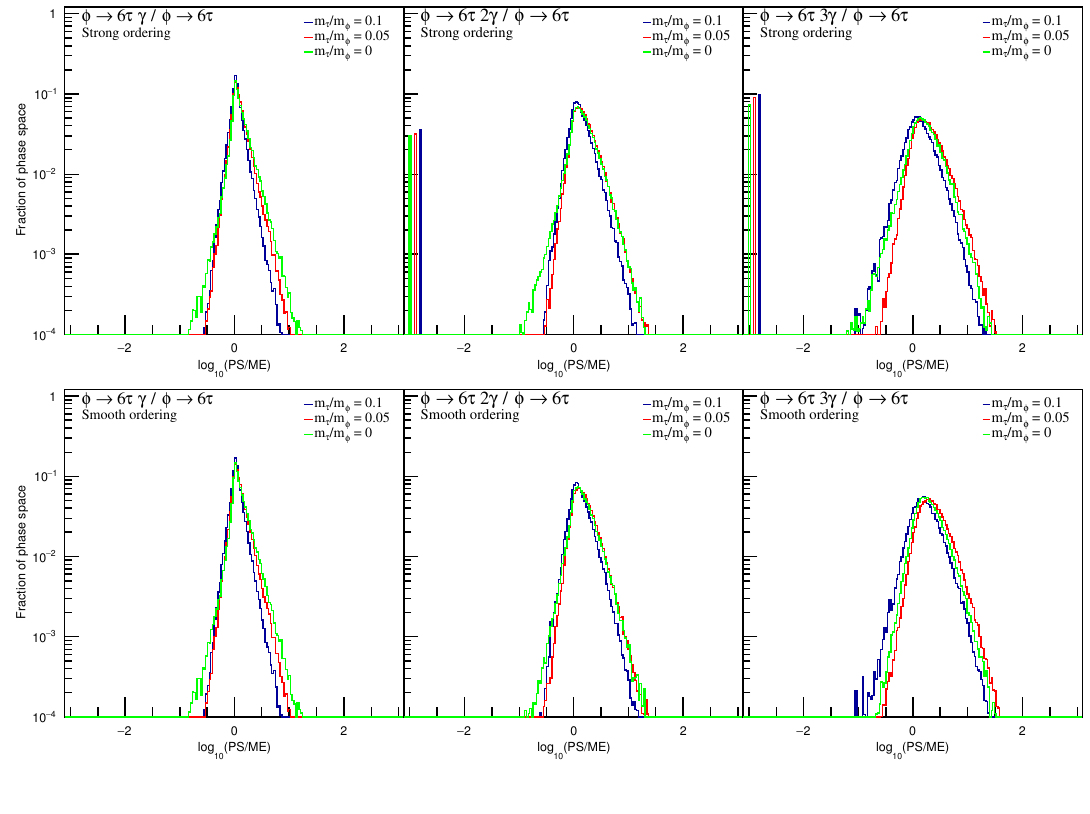
Figure 6 . Comparison of the shower approximation to matrix elements for one, two and three emissions from (cid:30) ! 6 (cid:28) using strong and smooth